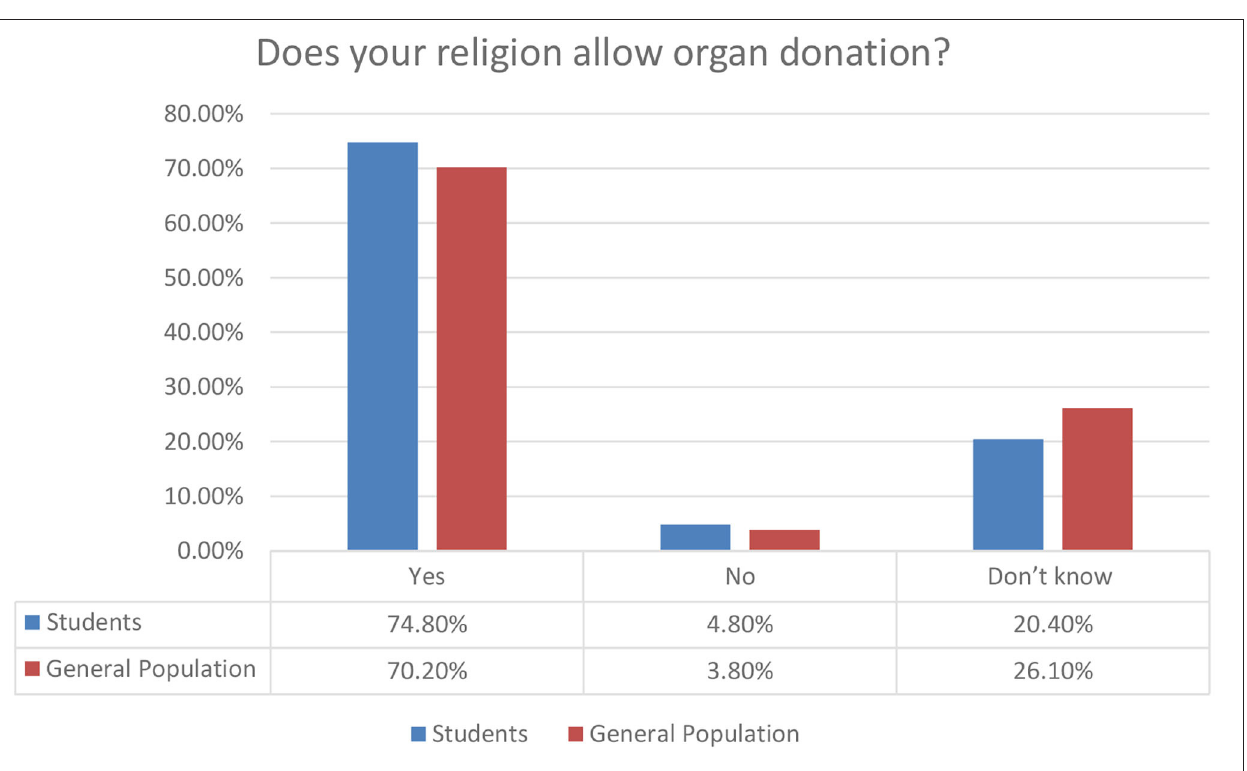
FIGURE 3 | Religion impact on organ donation perceptions.